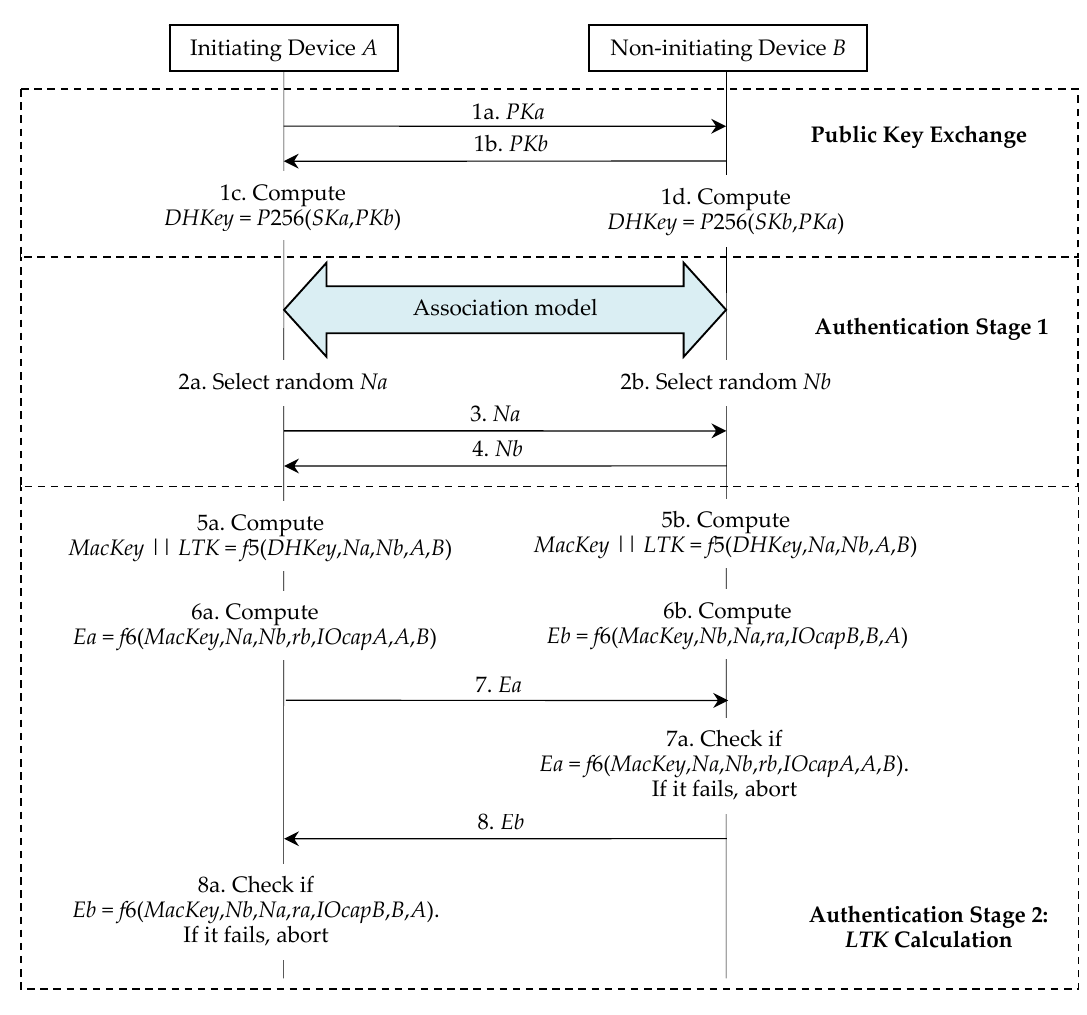
Figure 3. LESSP protocol Π *.